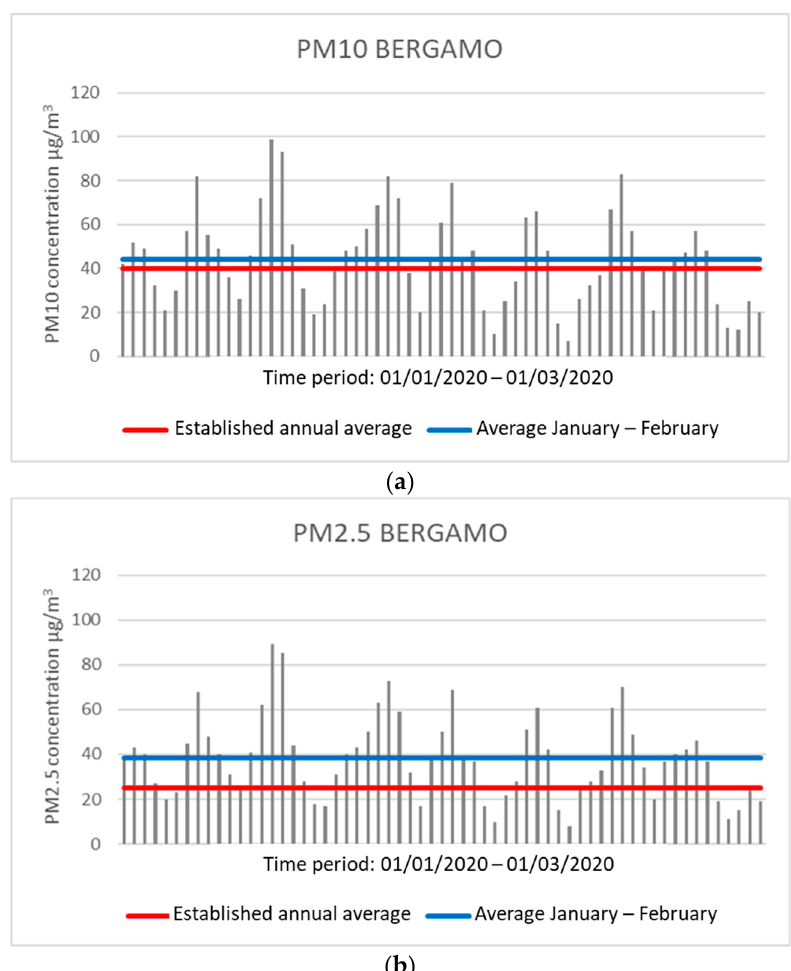
Figure 1. Graphs showing the concentration values of PM10 (a) and PM2.5 (b) in Bergamo. The red line indicates the expected regulatory limit, while the blue line indicates the average in the two months analyzed (analysis processed with data collected by ARPA (Regional Environmental Protection Agency)).